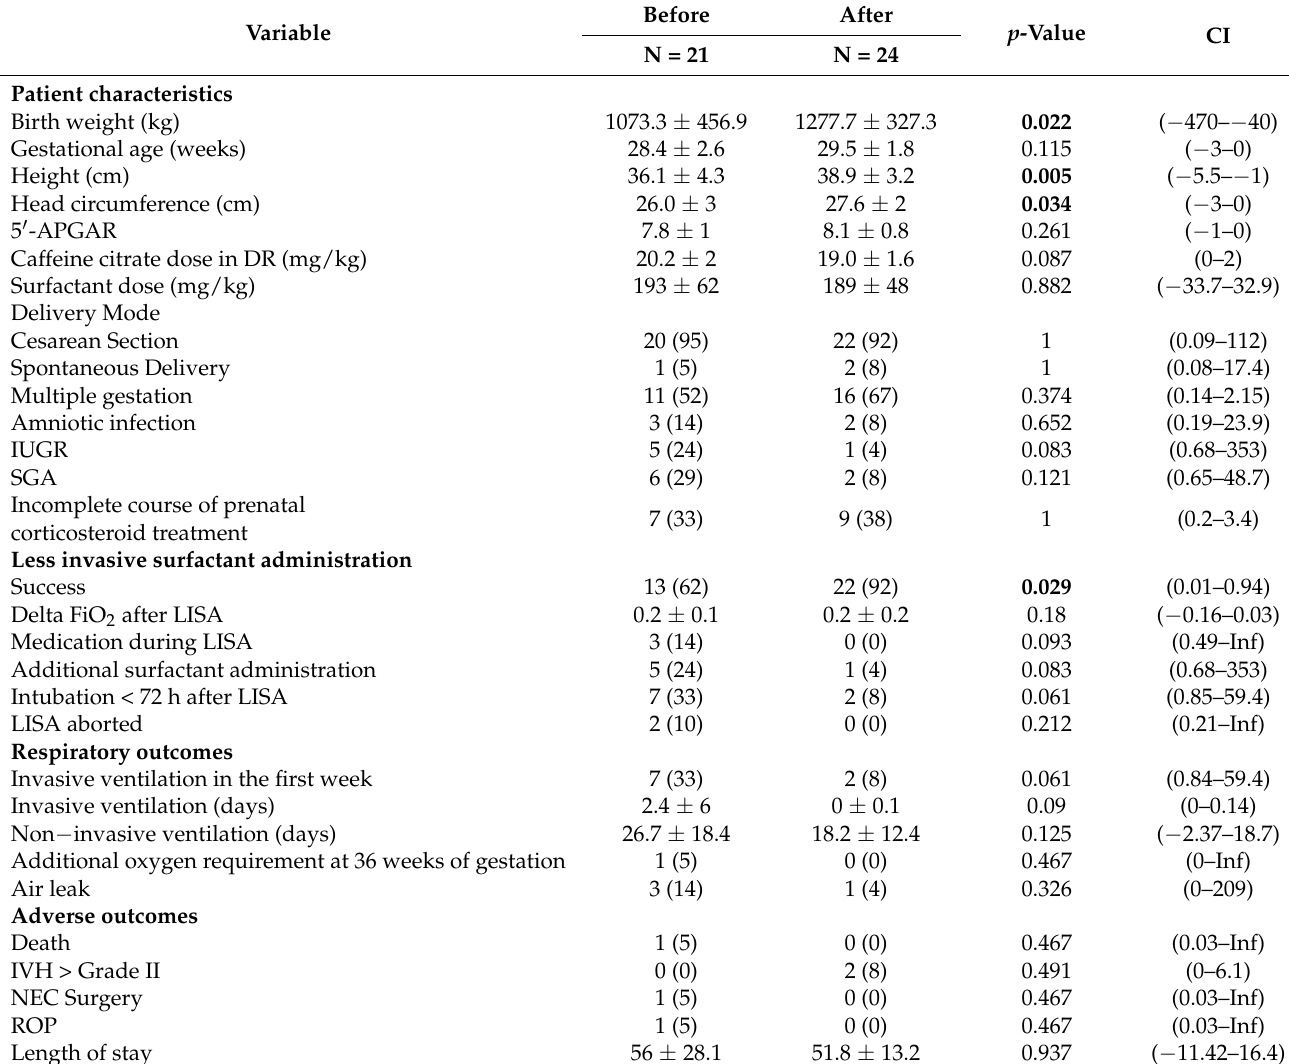
Table 1. Patient characteristics and in-hospital outcome before and after the